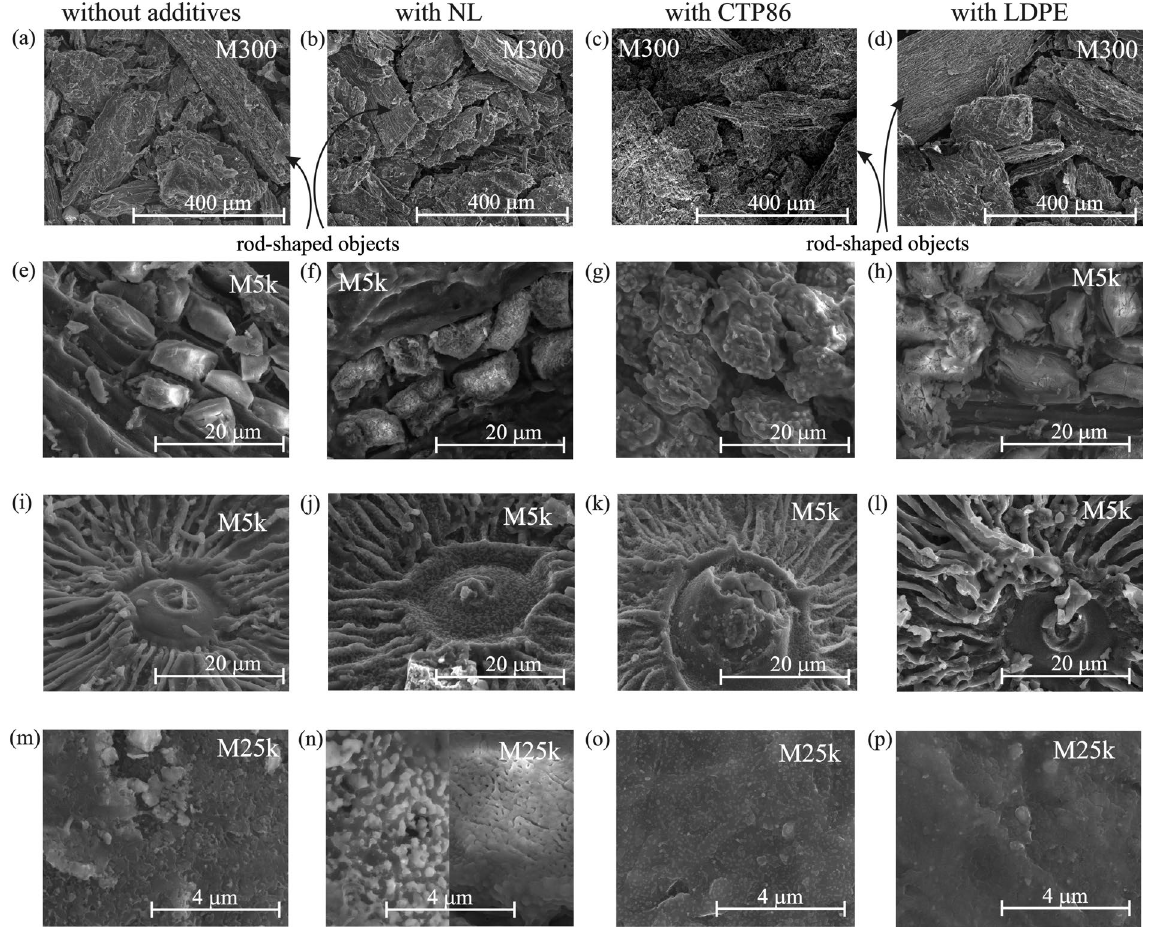
Figure 9. The SEM images of chars of densified PH sample and its blend with additives ( a ) char surface of PH; ( b ) char surface of PH with NL; ( c ) char surface of PH with CTP; ( d ) char surface of PH with LDPE; ( e ) ‘bricks’ in char from PH; ( f ) ‘bricks’ in char from PH with NL; ( g ) ‘bricks’ in char from PH with CTP; ( h ) ‘bricks’ in char from PH with LDPE; ( i ) ‘star’ in char from PH; ( j ) ‘star’ in char from PH with NL; ( k ) ‘star’ in char from PH with CTP; ( l ) ‘star’ in char from PH with LDPE; ( m ) flat surface of char from PH; ( n ) flat surface of char from PH with NL; ( o ) flat surface of char from PH with CTP; ( p ) flat surface of char from PH with